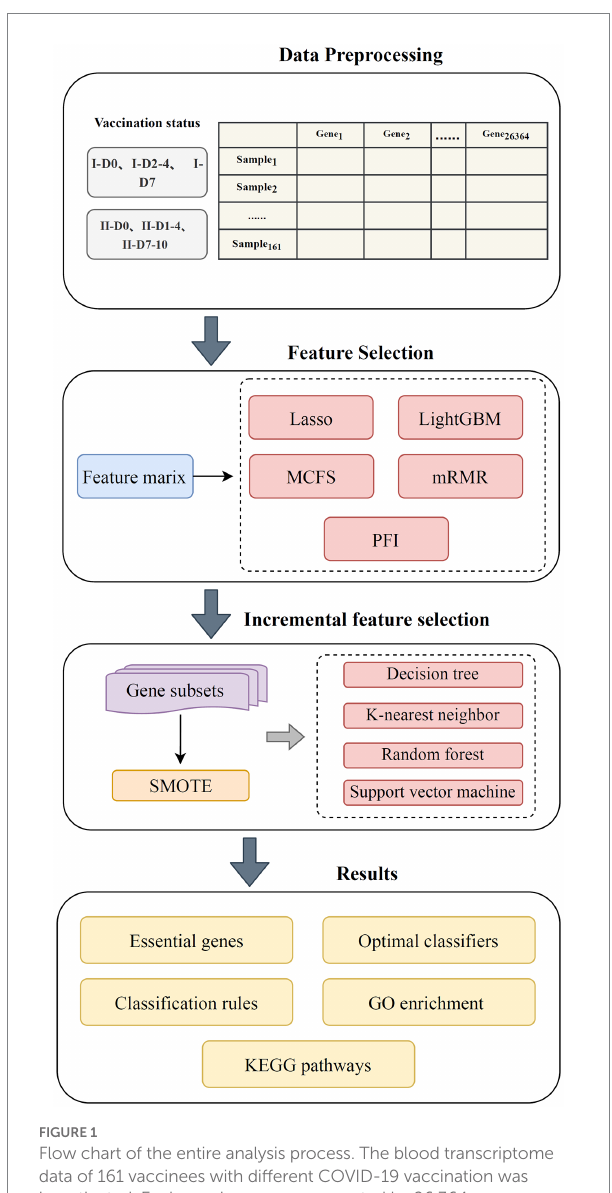
FIGURE 1 Flow chart of the entire analysis process. The blood transcriptome data of 161 vaccinees with different COVID-19 vaccination was investigated. Each vaccinee was represented by 26,364 gene expression levels. Five feature ranking algorithms (Lasso, LightGBM, MCFS, mRMR, and PFI) were used to rank gene features according to their importance. Subsequently, these lists were fed into incremental feature selection method, which contained four classification algorithms, to extract essential genes, classification rules, and build optimal